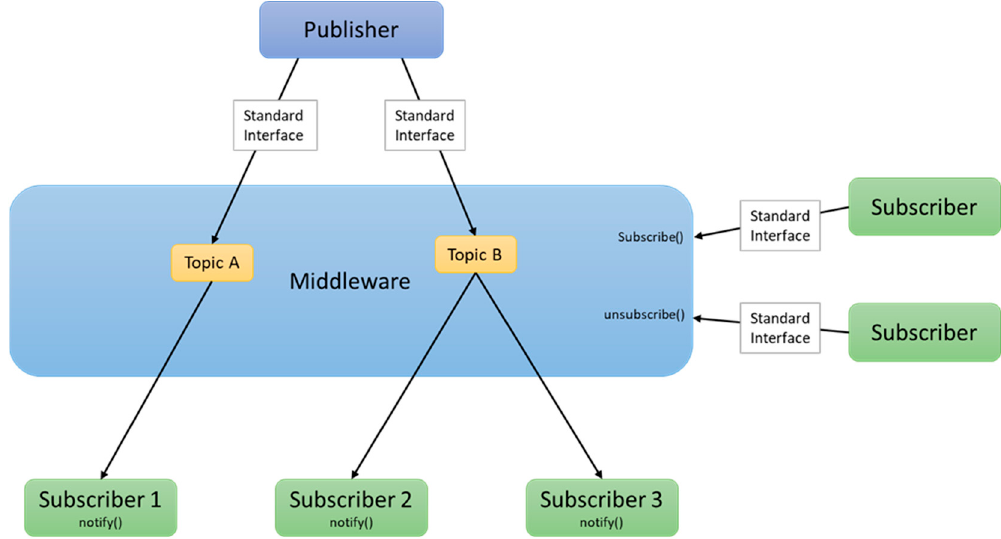
Figure 2. Publish/Subscribe Model.